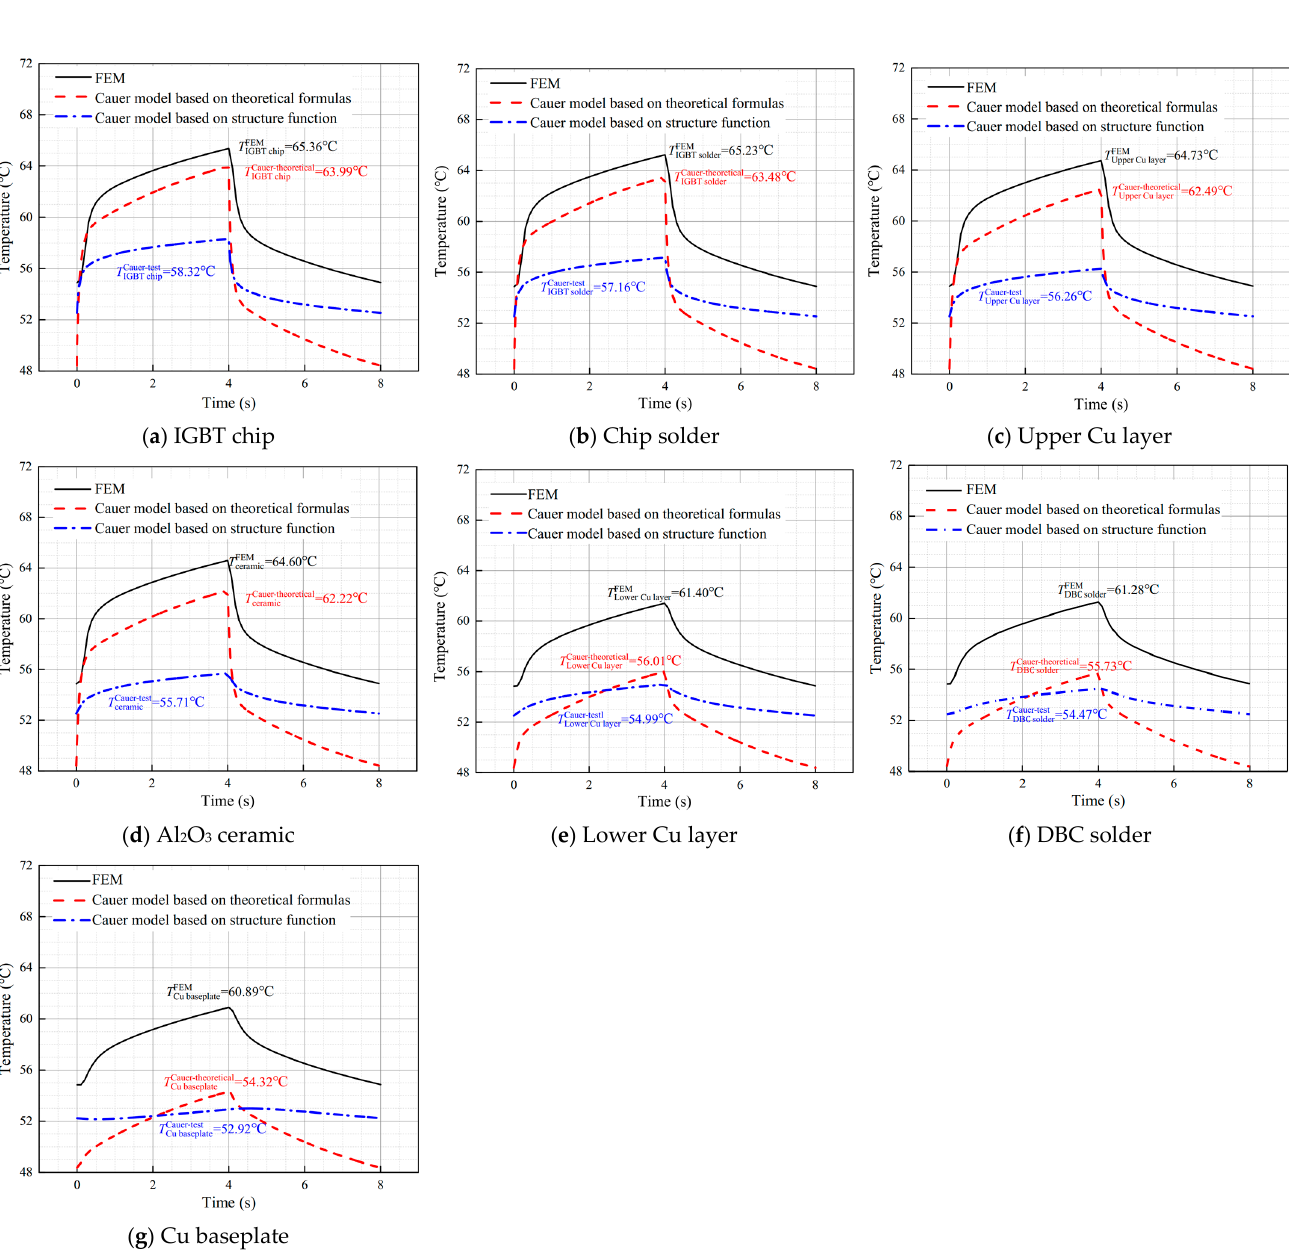
Figure 16. Comparison of the Cauer model calculation results and FE calculation results for each material layer under DC-1 conditions. Table 6. Verification of the Cauer thermal network models under DC-1 conditions by FE analysis.